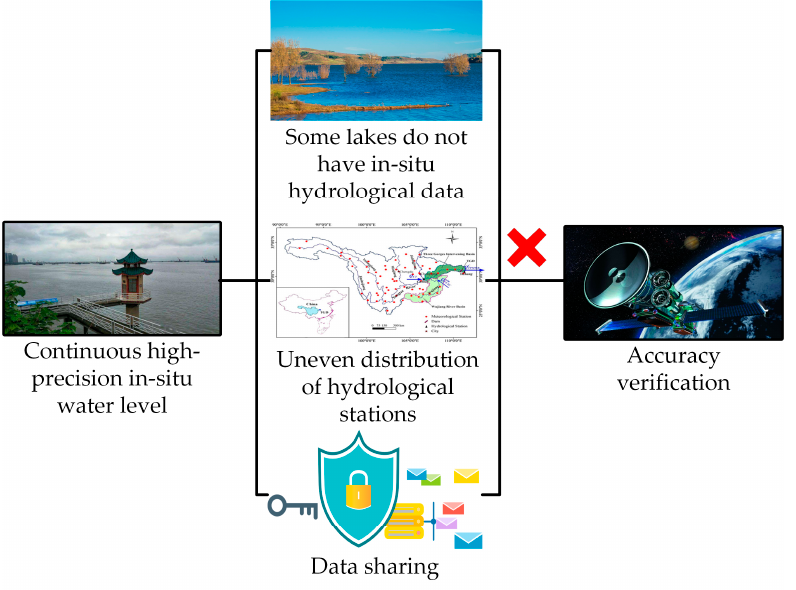
Figure 6. The problem of accuracy verification of altimeter satellite.